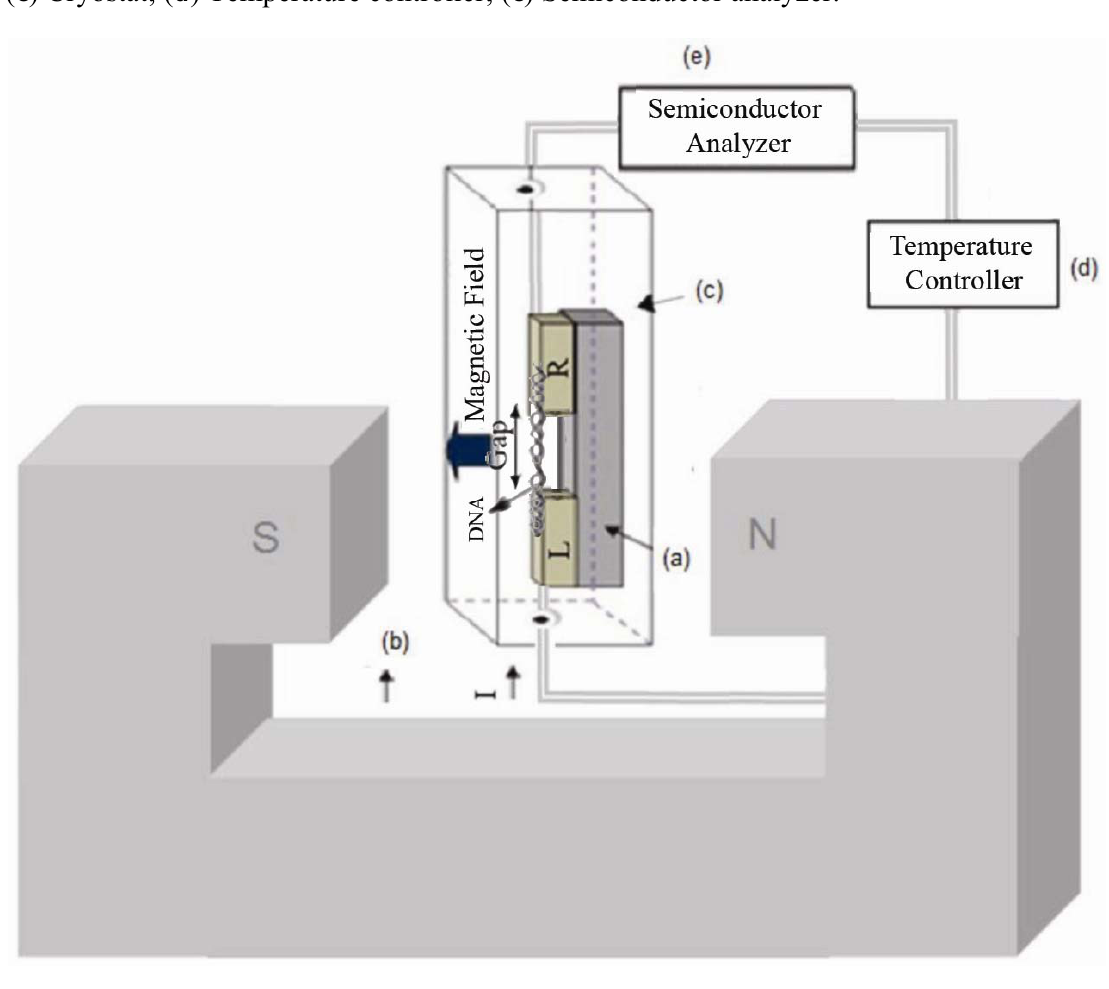
Figure 2. Two electrodes L and R (L = left, R = right) with an insulator gap in the gold- DNA-gold structure in the presence of external magnetic field is placed inside cryostat connected to temperature controller, semiconductor analyzer. ( a ) MDM; ( b ) Electromagnet; ( c ) Cryostat; ( d ) Temperature controller; ( e ) Semiconductor